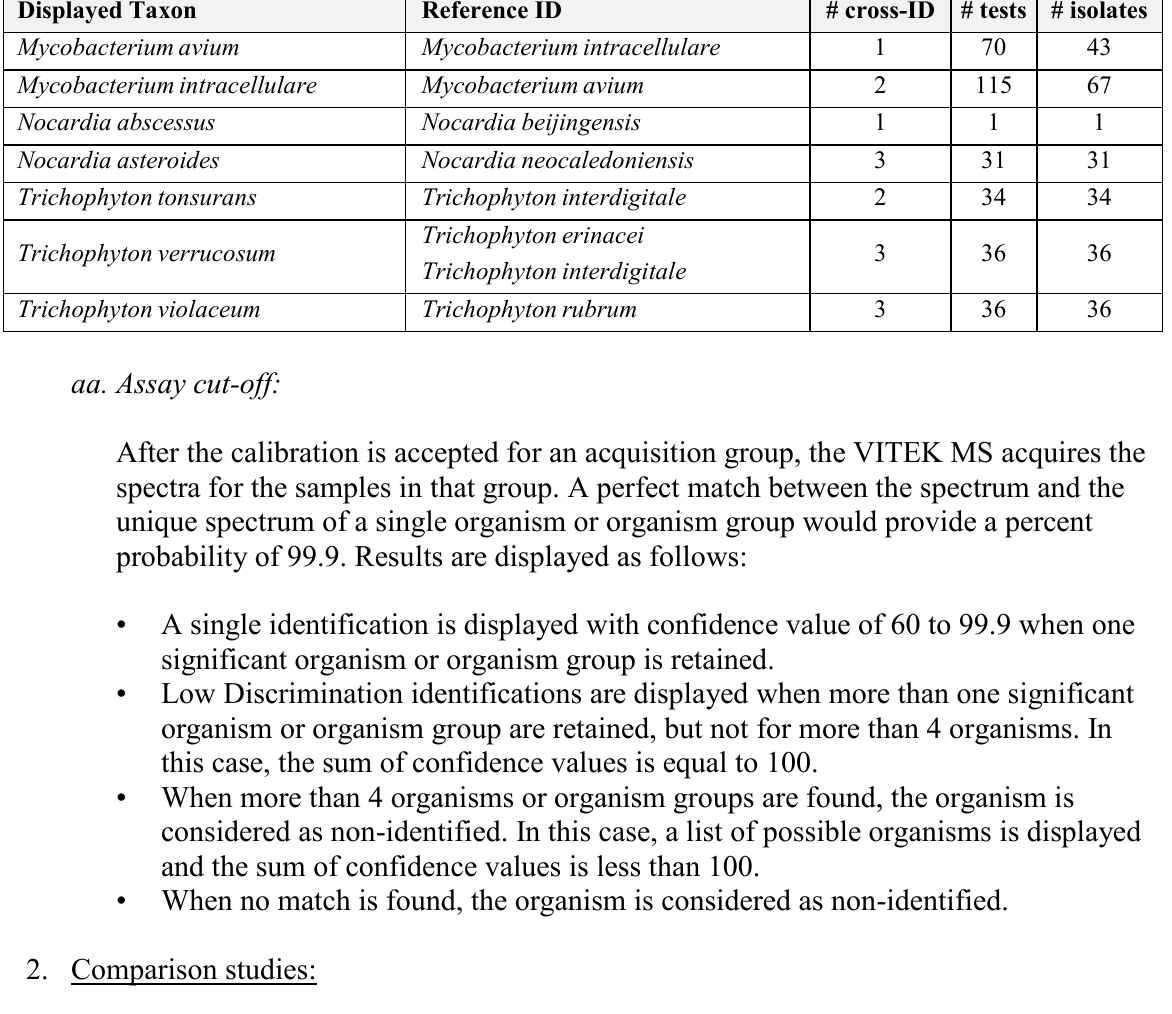
TABLE 10: Cross-identification between VITEK MS claimed displayed taxa Displayed